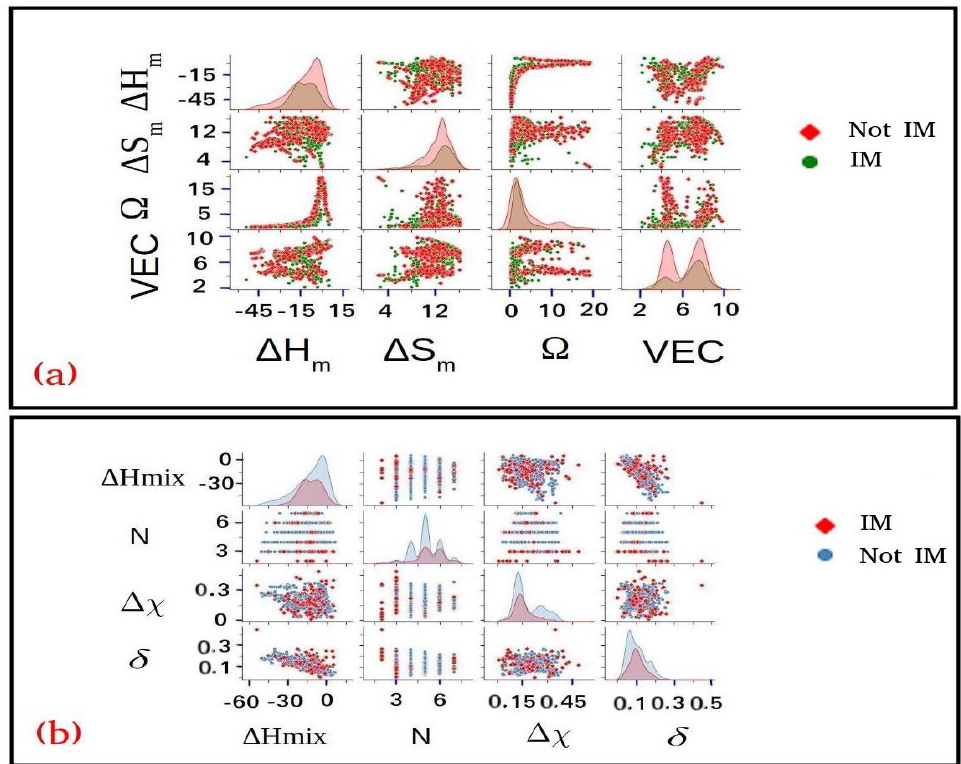
Figure 2. Pairplots for visualization of the different features of the collected dataset. The fingerprints— namely, mixing enthalpy ( ∆ H mix or ∆ H m ), mixing entropy, Ω and VEC—are ploted in ( a ), whereas the scatter distributions of mixing enthalpy, number of components ( N ), electronegativity and atomic size difference are compared in ( b ). The scattered data are classified as IM and Not IM. It is to be noted that IM represents that the system can have either an intermetallic compound (IMC) phase or can be the IMC in combination with other phases such as AM, SS, FCC, and BCC. Not IMC simply means that a given MPEA does not have an IMC